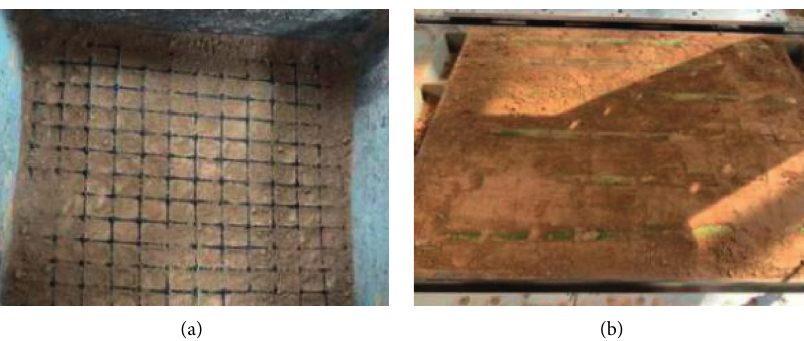
Figure 10: Laying of the material in the lower shear box. (a) Laying the geogrid. (b) Laying the bamboo tendon grating.